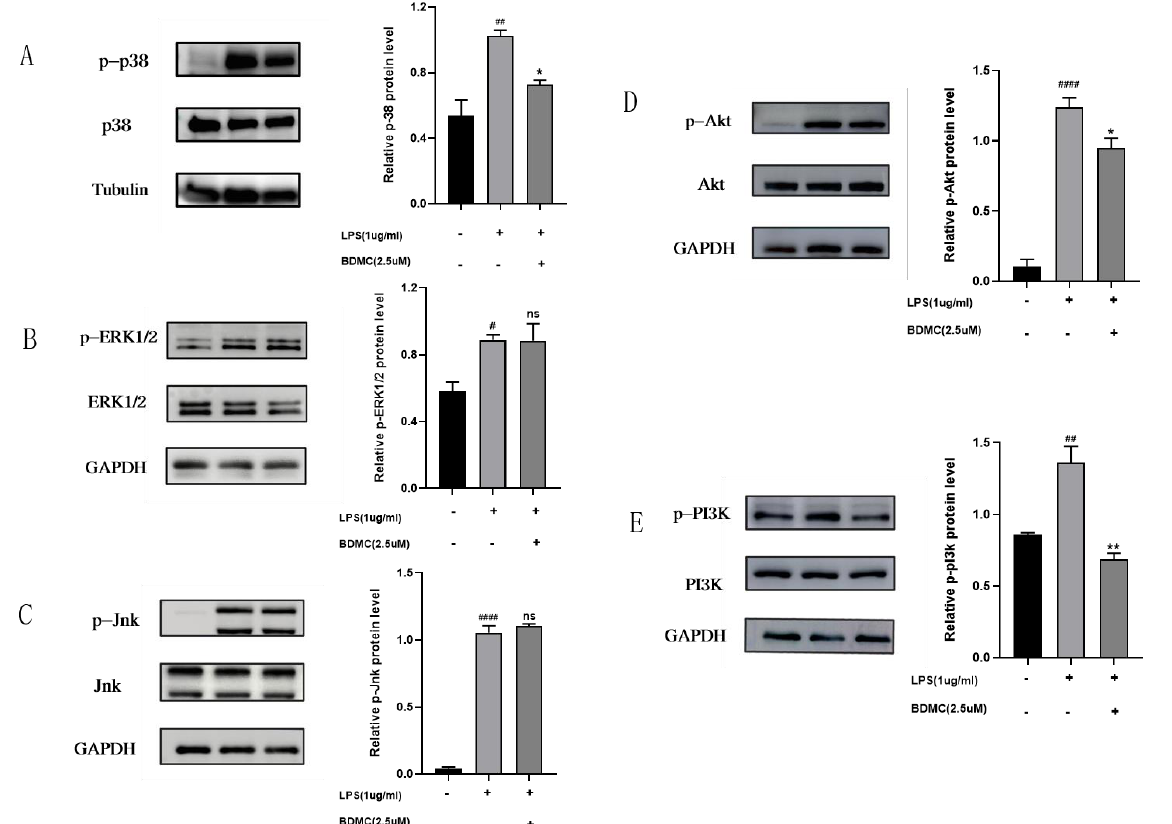
Figure 7. The protein expression levels of p-p38, p38, p-ERK1/2, ERK1/2, p-Jnk, Jnk, p-Akt, Akt, p-PI3k, PI3k, GAPDH, and tubulin in LPS-induced RAW264.7 after giving BMDC. ( A ) The protein expression levels of p-p38, p-38. ( B ) The protein expression levels of p-ERK1/2, ERK1/2. ( C ) The protein expression levels of p-Jnk, Jnk. ( D ) The protein expression levels of p-Akt, Akt. ( E ) The protein expression levels of p-PI3K, PI3K.Data are presented as the mean ± SEM. # p < 0.05, ## p < 0.01; #### p < 0.001 vs. control group; * p < 0.05; ** p < 0.01 vs. LPS group. ns mean non-significant vs. LPS